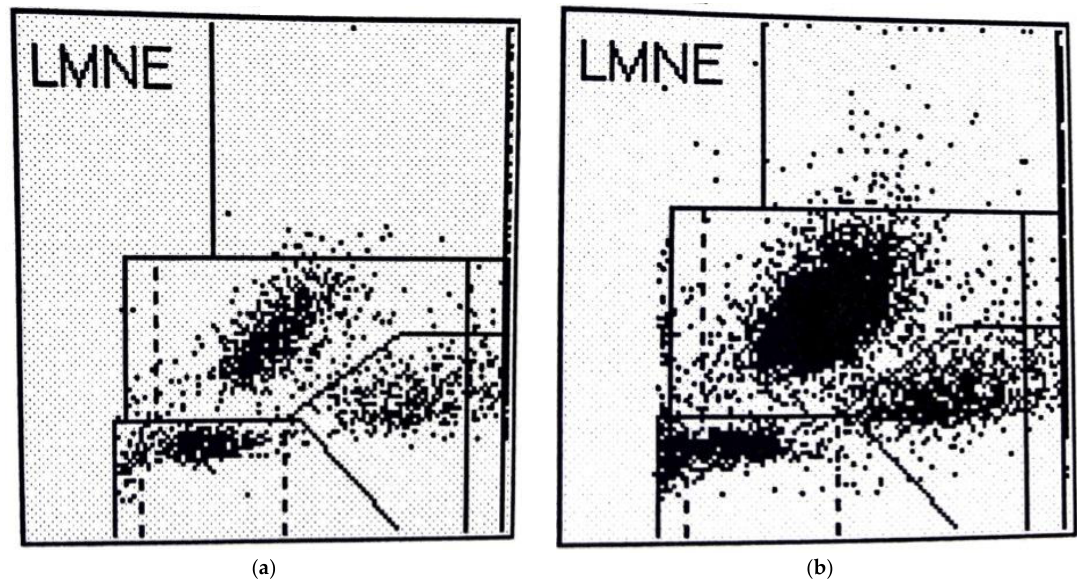
Figure 4. ( a ): LMNE matrix of a type V (hematoma type) of a 71 year old woman 6 weeks after hip arthroplasty with a hematoma. The measured cell count was 3560 cells/µL with 63.5% PMN; the CRP was 143.7 mg/L (<5 mg/L is normal). ( b ): LMNE matrix of a type V (hematoma) 74-year-old female patient with a hematoma 6 weeks after hip arthroplasty. There is a cluster in the field of the lymphocytes and another clear cluster in the field of the neutrophils. The measured cell count was 11,400 cells/µL with 79.1% PMN and the CRP was 86.9 mg/L.